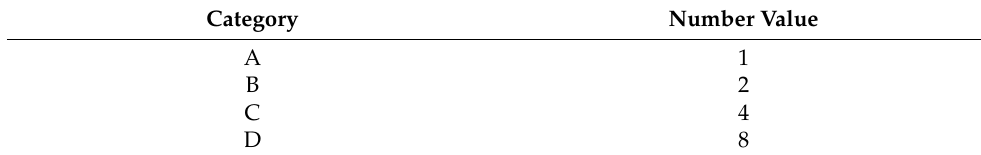
Table 12. Conversion of the letter categories of the consequences into numerical values [24].